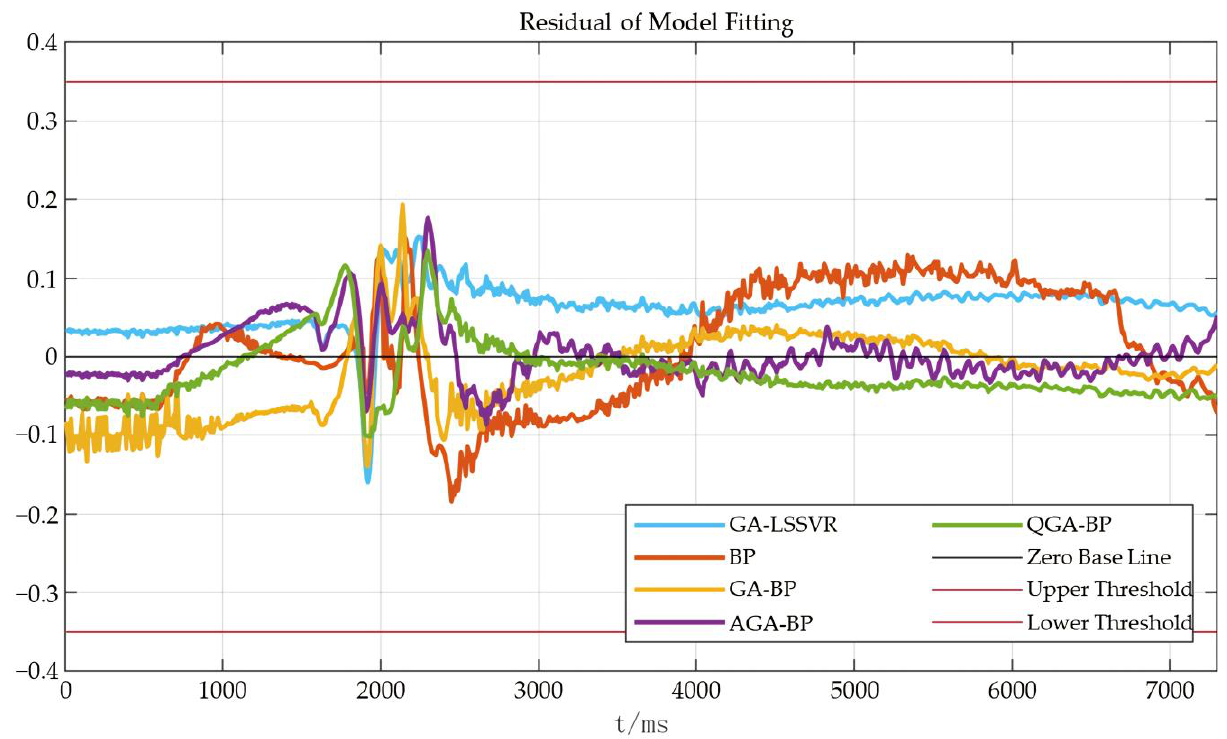
Figure 7. BP, GA-BP, AGA-BP, QGA-BP, GA-LSSVR fitting residual diagram: normal test data.